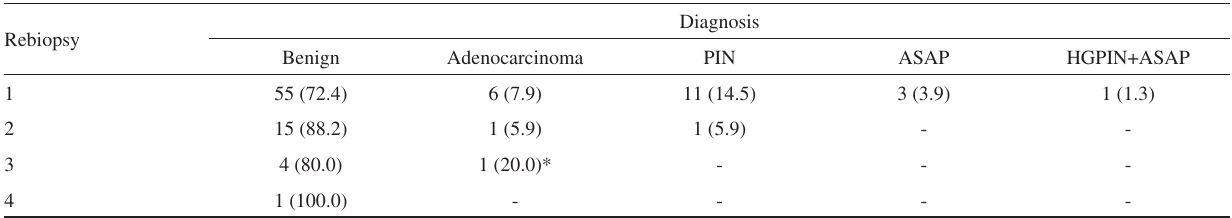
Table 2 ­ Rebiopsies after benign diagnosis in 76 patients